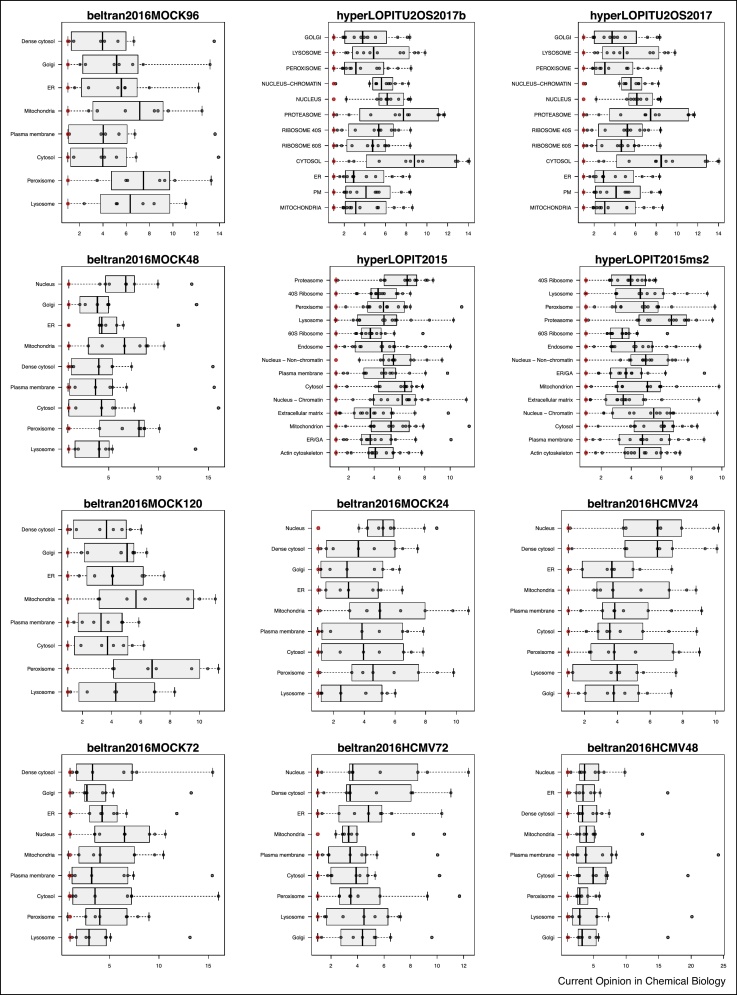
Quantitative separation boxplot for the 29 experiments used in this study. The experiments are ordered according to the median average between cluster distance (see Figure 8).